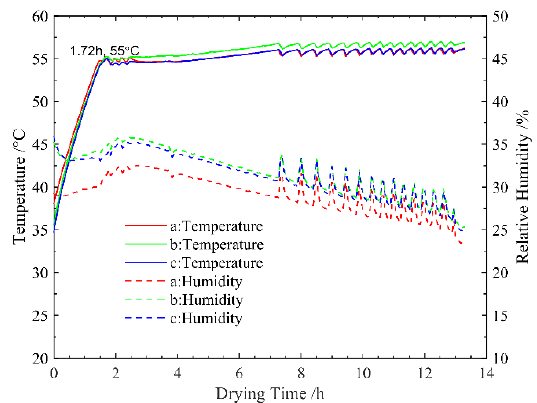
Figure 7. Temperature and humidity of drying chamber.